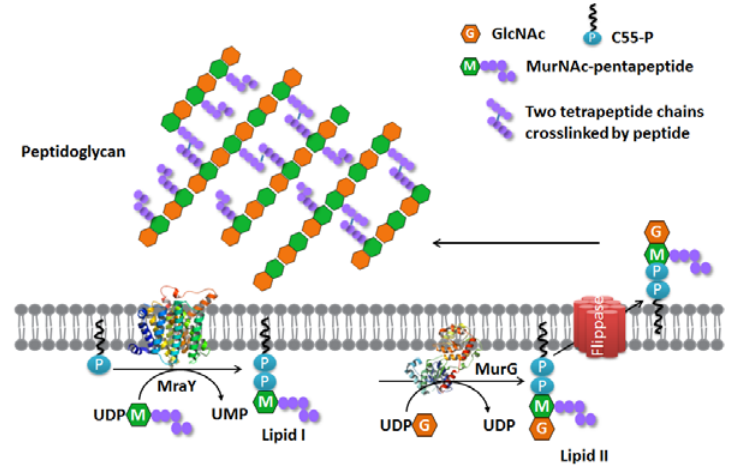
Figure 1. Membrane steps of the bacterial peptidoglycan synthesis pathway.